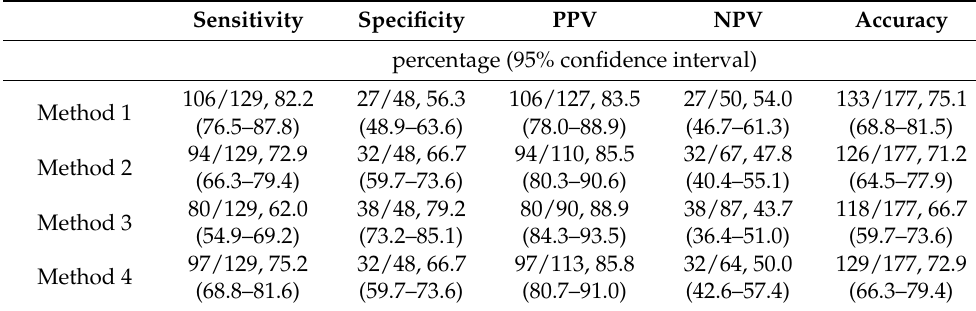
Table 2. Diagnostic performance of knee stress radiography for the detection of anterior cruciate ligament tear.